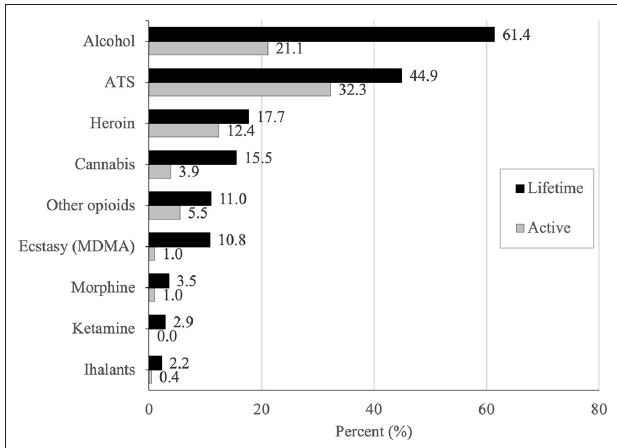
FIGURE 1 | Lifetime and active history of substance use among sex workers who are cisgender or transgender women, in Greater Kuala Lumpur,